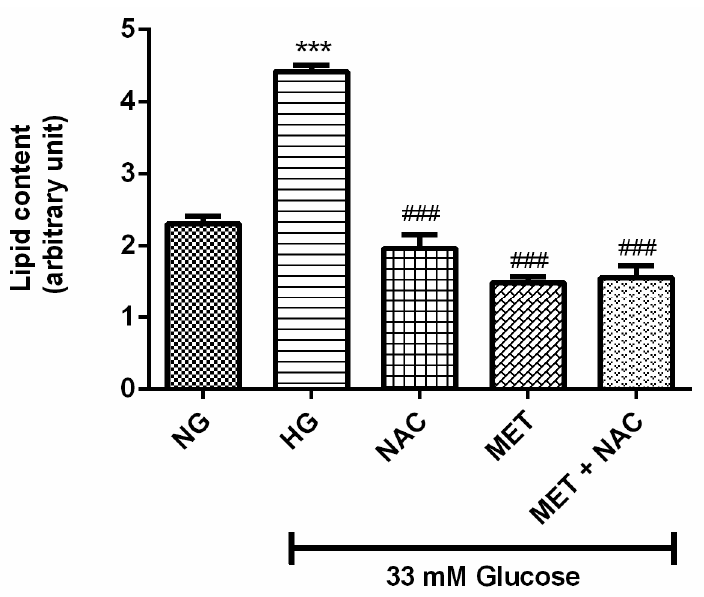
Figure 3. The combination effect of Metformin (MET) and N-acetylcysteine (NAC) to reverse high glucose-induced lipid accumulation. H9c2 cardiomyoblasts were cultured in high glucose (HG; 33 mM) for 24 h. Cells were then co-treated with NAC (1 mM), metformin (MET) (1 µ M) and a combinatory treatment of MET + NAC. Cells treated with normal glucose (NG) served as the vehicle control. Results are expressed as the mean ± SEM of 3 independent biological experiments with each experiment having 3 technical replicates ( n = 9). Significance is depicted as *** p ≤ 0.001 versus NG control, ### p ≤ 0.001 versus HG control.